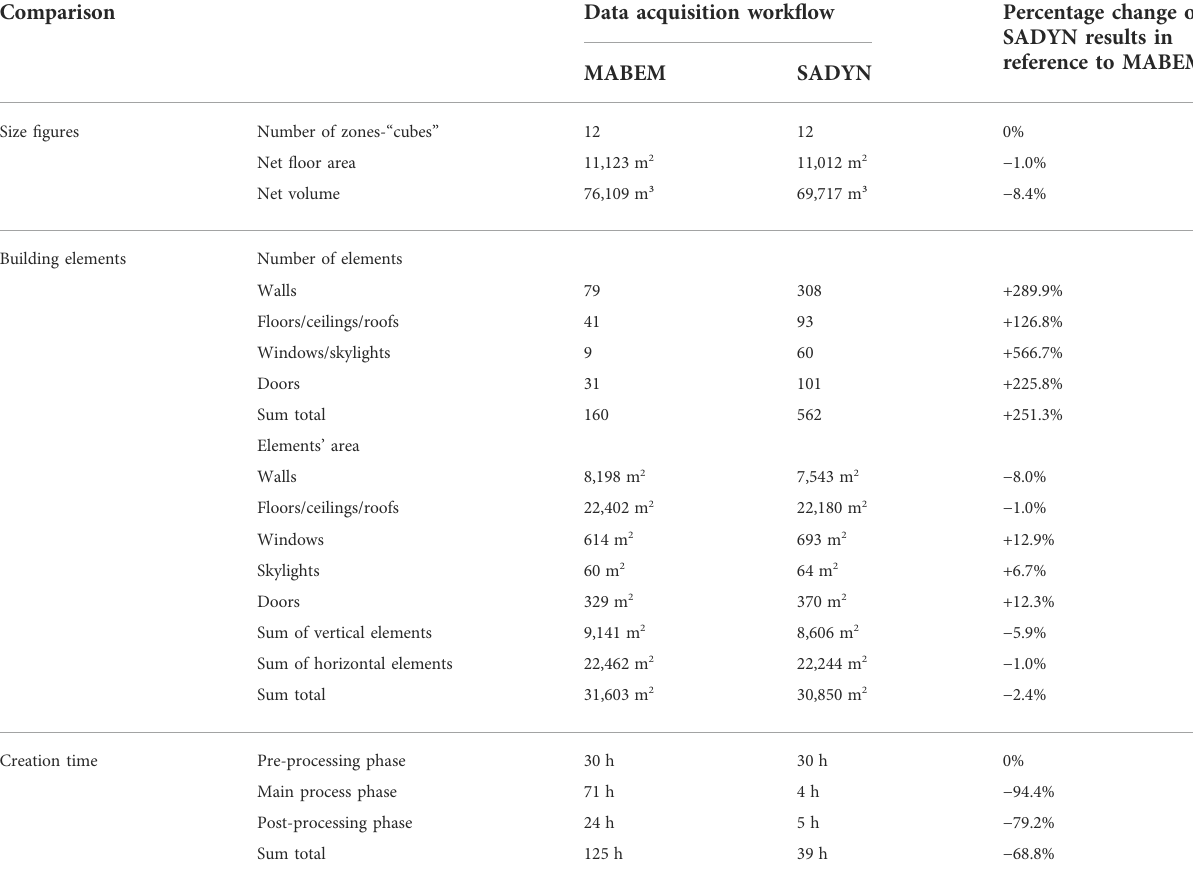
TABLE 2 Comparison of case study data for BaMa